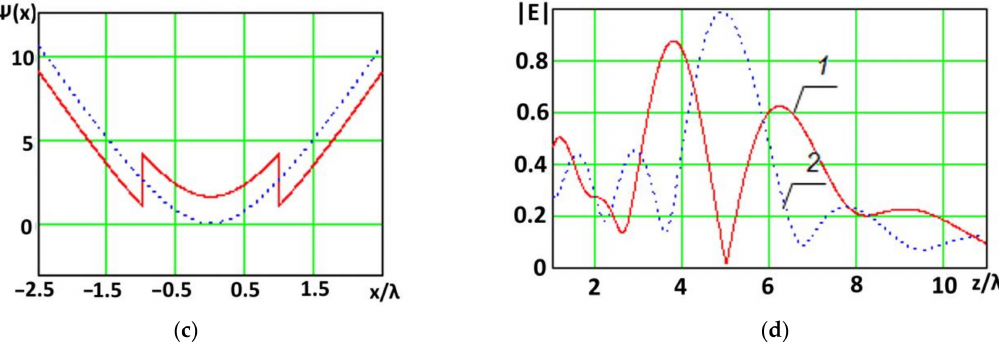
Figure 13. Phase distributions Ψ 1 ( x , z 0 ) and Ψ 2 ( x , z 0 ) and the corresponding sum–difference-type radiation patterns formed in planes parallel and perpendicular to the aperture: ( a ) phase distribution Ψ ( x , z ) of the first type; ( b ) sum–difference distribution of the electric field strength in a plane paral- 0 1 lel to the aperture: 1—sum radiation pattern, 2—differential radiation pattern; ( c ) phase distribution Ψ ) of the second type; ( d ) sum–difference distribution of the electric field strength in a plane ( x , z 0 2 parallel to the aperture: 1—sum radiation pattern, 2—differential radiation